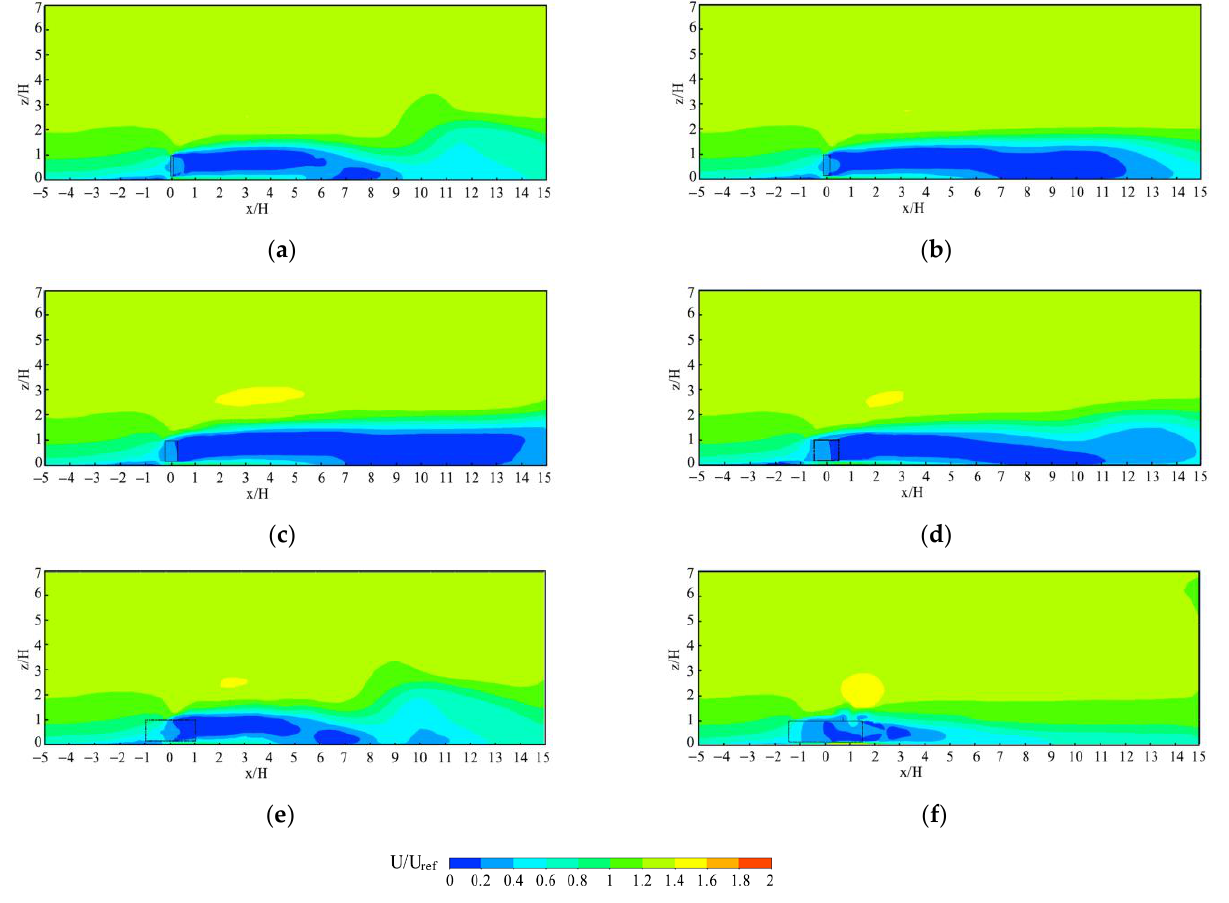
( b ) Figure 7. ( a ) Perspective view from the east, where red is the Grotto Zone, ( b ) topography map of the focused terrain. The numerical simulation of the flow fields is divided into two levels. At the higher level, in order to reflect the influence of upstream terrain on the wind flow characteristics [34], a terrain model with a horizontal resolution of 20 m within a 10 km ×10 km region is established based on a geographic information system (GIS) data (Figure 8). According to guidelines for CFD practices in wind engineering [44,45], the height of the computational domain is five times the maximum elevation difference in the region. Note that the height of the computational domain in this paper is similar to the atmospheric boundary layer